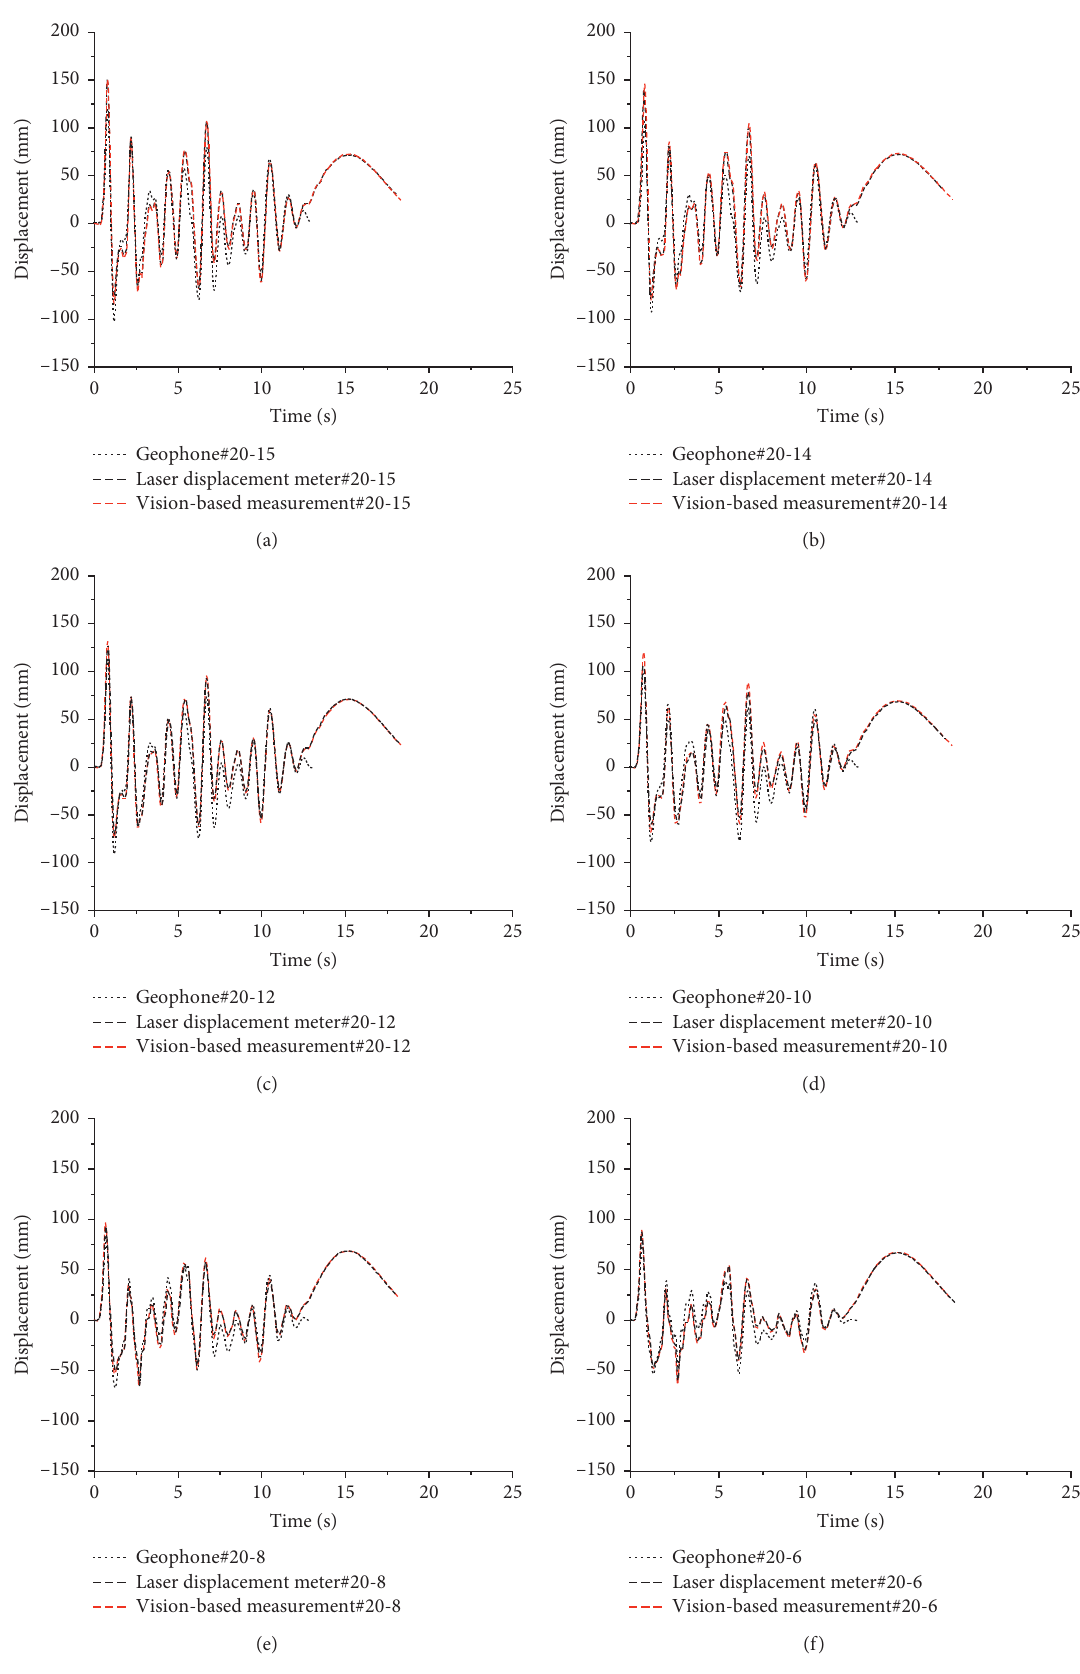
Figure 11: Working condition 20. (a) Fifteenth floor. (b) Fourteenth floor. (c) Twelfth floor. (d) Tenth floor. (e) Eighth floor. (f) Sixth